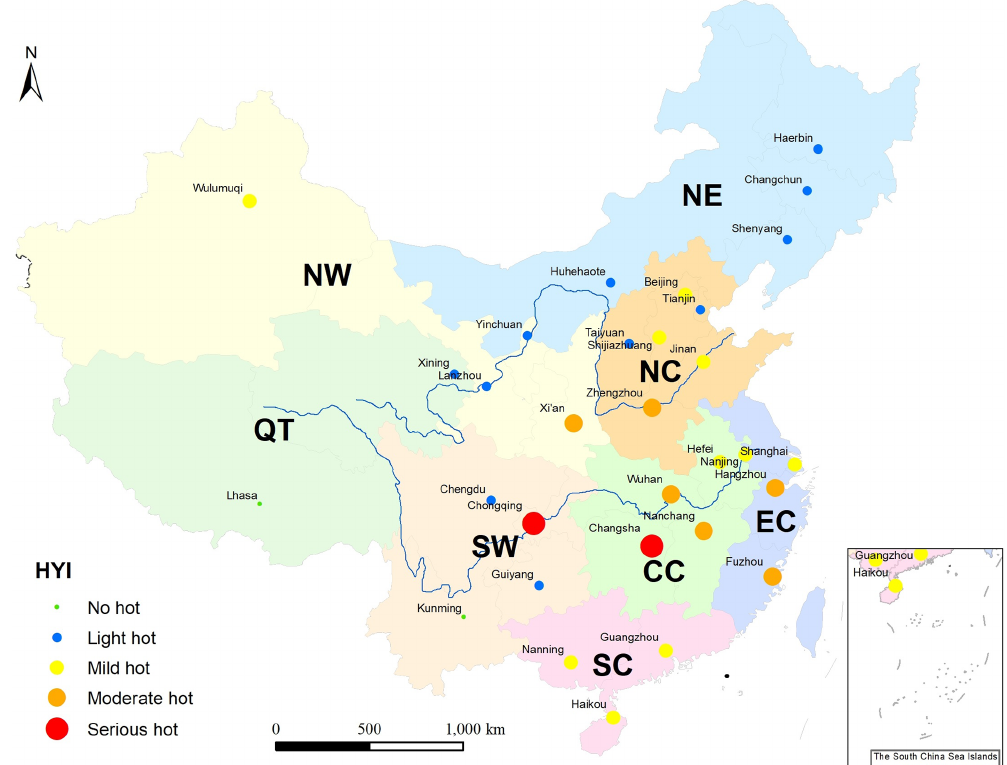
Figure 9. Classification of annual average of HYIs from 1955 to 2014 in 31 cities in the study area (the climate zones include NE, NW, NC, CC, EC, SC, SW and QT; the upper blue line: the Yellow River; the lower blue line: the Yangtze